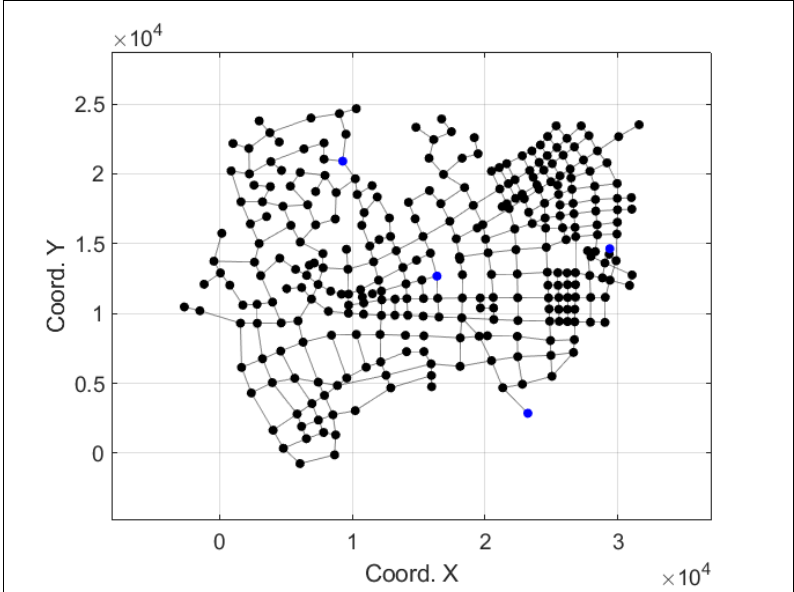
Figure 6. Layout of a sensor network with four sensors using the conditional entropy as input for fuzzy DEMATEL.